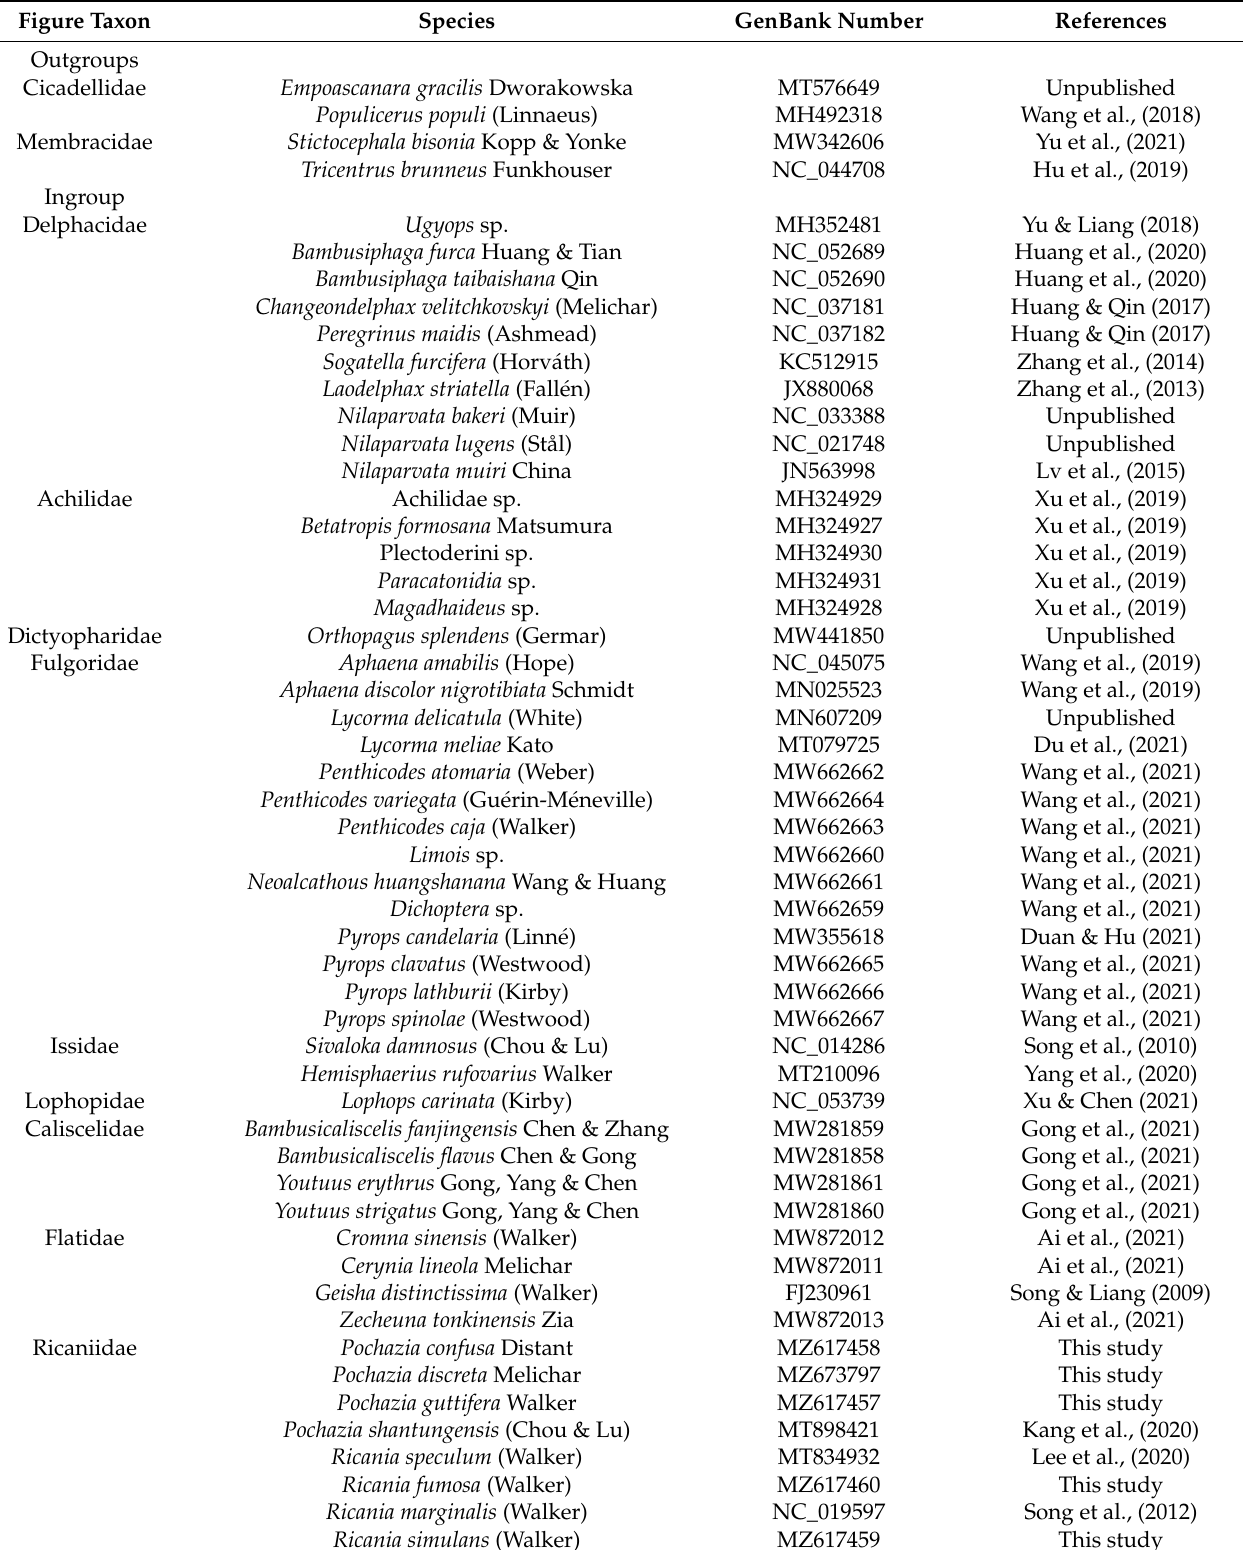
Table 1. Taxa used in this